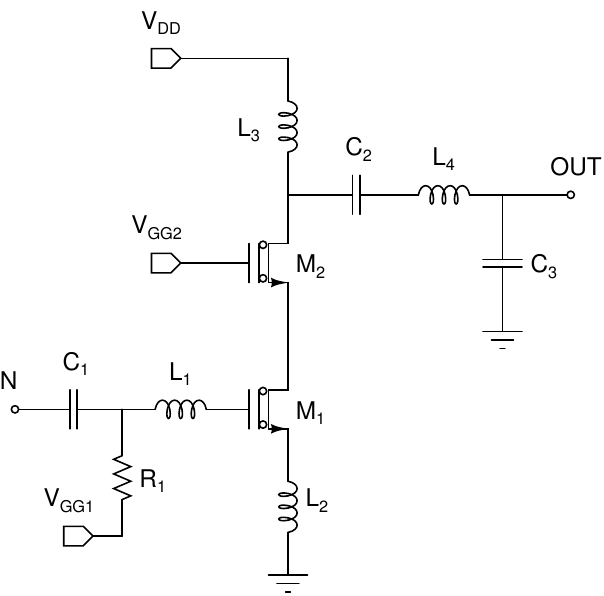
Figure 6. Schematic of the cascode CNT-FET high-power amplifier.